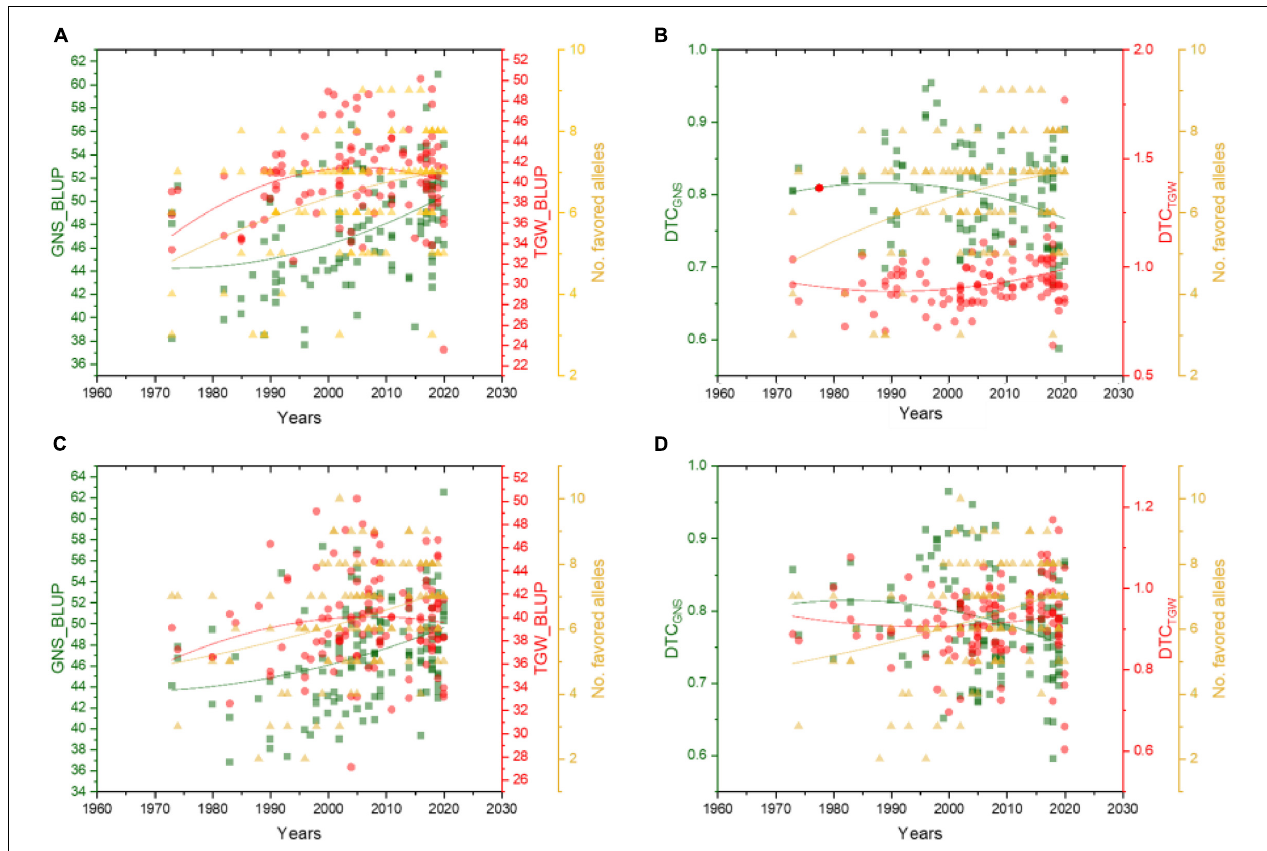
FIGURE 5 | Effect of favorable alleles on GNS, TGW, and their DTC values in dryland (A,B) and irrigated wheat (C,D) over the years. The red dots represent TGW_BLUP (A,C) and DTC TGW (B,D) , green squares represent GNS_BLUP (A,C) and DTC GNS (B,D) , yellow triangles represent the number of favored